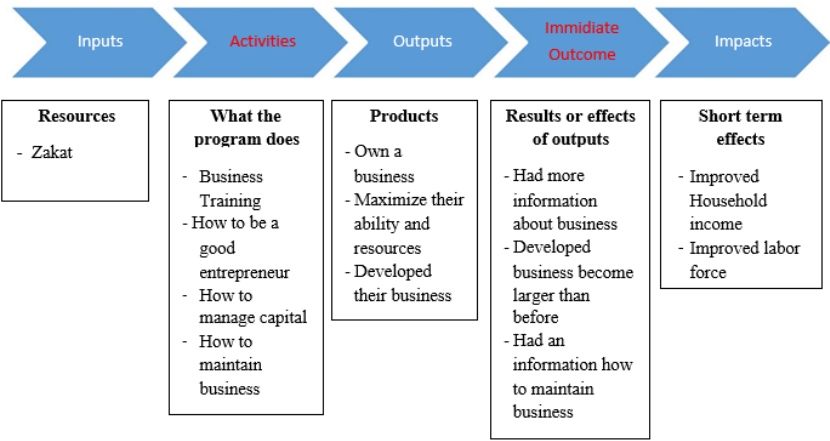
Figure 4 Result Chain Flowchart of DPU-Daarut